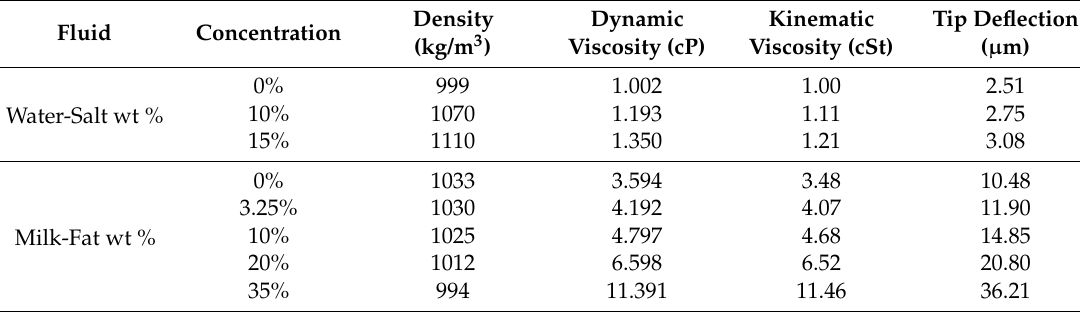
Table 1. Changes in DI water-salt solution and milk with different fat content properties and experimental deflection results; both density and viscosity varied with salt and fat concentrations.